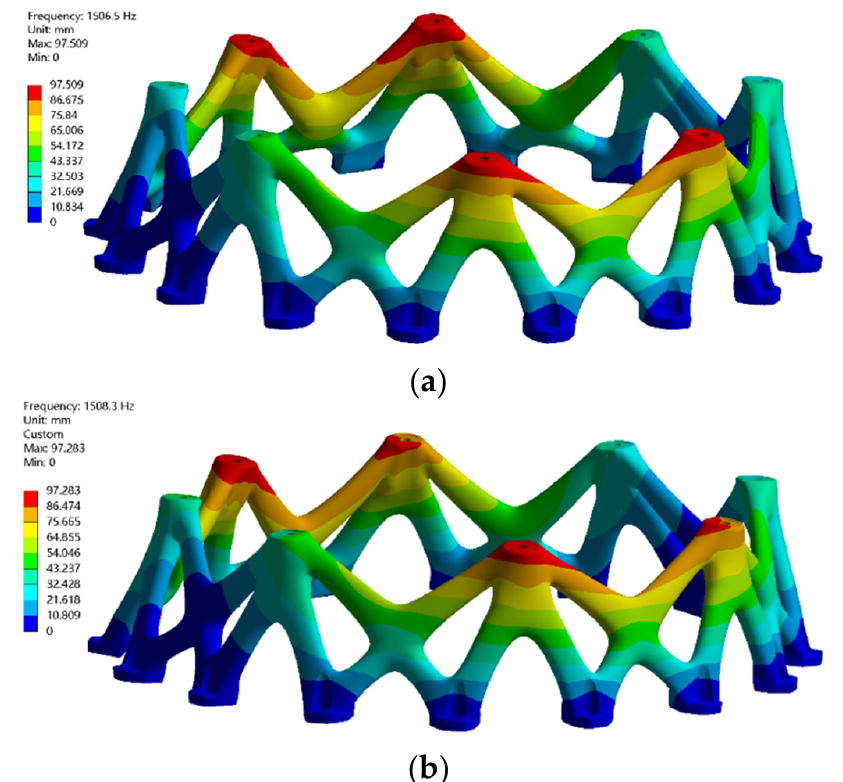
Figure 15. Mode shape of the first mode: ( a ) The detailed model; ( b ) The homogenization model. Table 3. Comparison frequencies of the first six modes of the detailed model and the homogenization model.